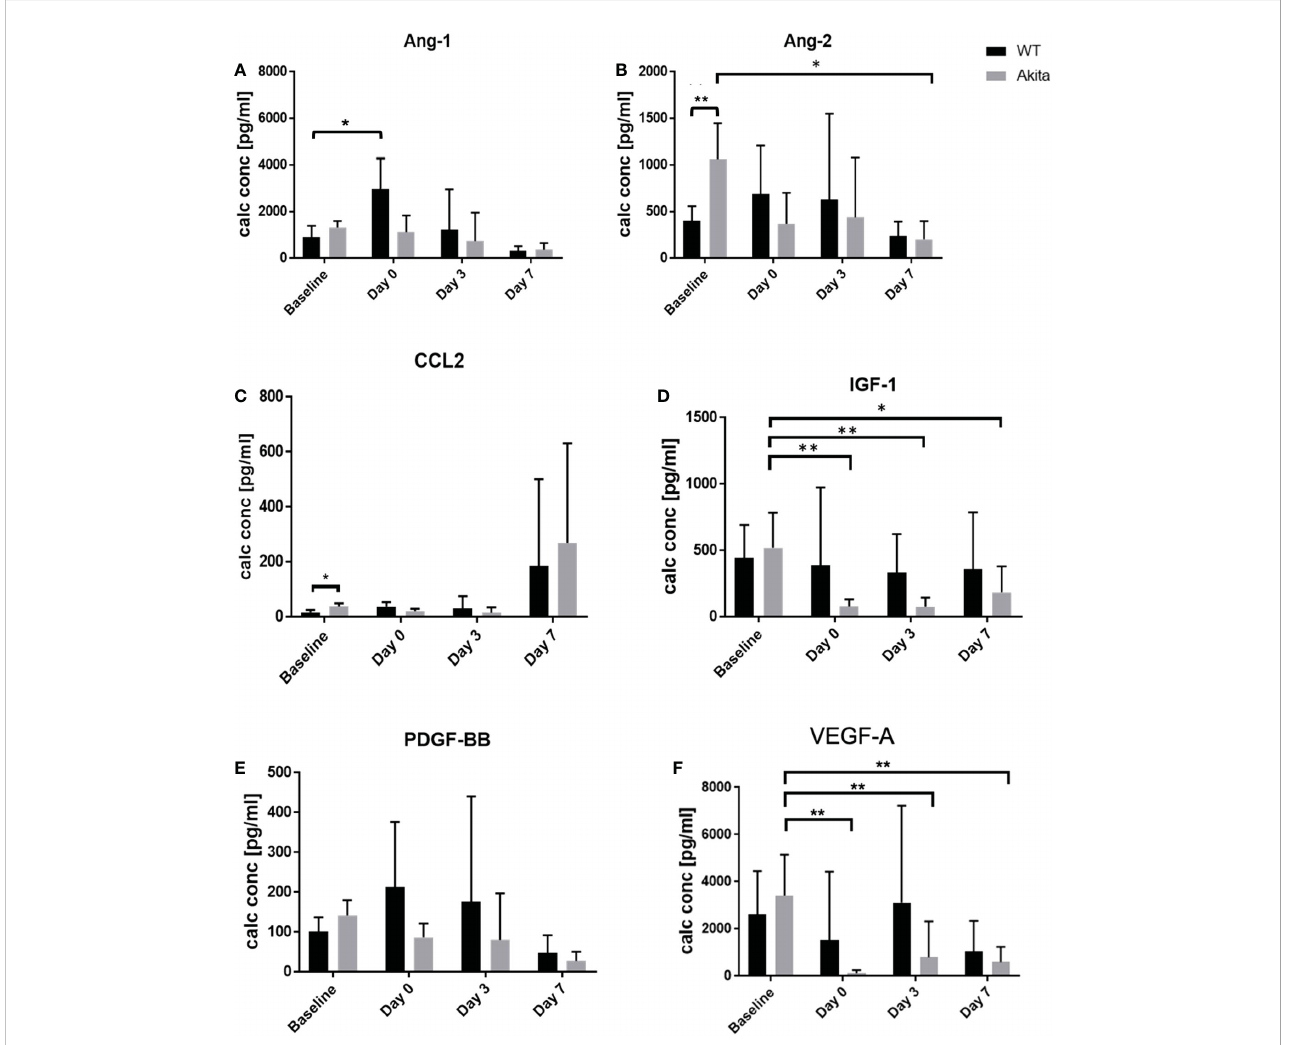
FIGURE 5 Comparison of tear protein concentration of the right (injured) eye from WT and Akita mice measured at baseline (before injury) with day 0, day 3, and day 7 after corneal alkaline injury. (A) Tear level of Ang-1 showed signi fi cantly elevated level immediately after injury WT mice ( n = 6, p = 0.0412). (B) Tear level of Ang-2 showed signi fi cantly higher tear level at baseline and has signi fi cantly decreased at day 7 after injury for Akita mice ( n = 6, p = 0.0243). (C) Tear level of CCL2 showed signi fi cantly elevated level in Akita mice at baseline. (D) Tear level of IGF-1 has signi fi cantly decreased immediately after injury ( n = 8, p = 0.0018), and on post-injury day 3 ( n = 8, p = 0.0026) and day 7 ( n = 8, p = 0.0147) in Akita mice. (E) Tear level of PDGF-BB showed a trend of decrease from baseline level to the post-injury period in tear levels of Akita mice; however, there was no statistical signi fi cance. (F) Tear level of VEGF-A for Akita mice has signi fi cantly decreased immediately after injury ( n = 8, p = 0.0016), on day 3 ( n = 8, p = 0.0063), and on post-injury day 7 ( n = 8, p = 0.0032) compared to baseline level ( n number means the number of eyes/mice from both the WT and Akita groups, same for all measurements). *p<0.05;